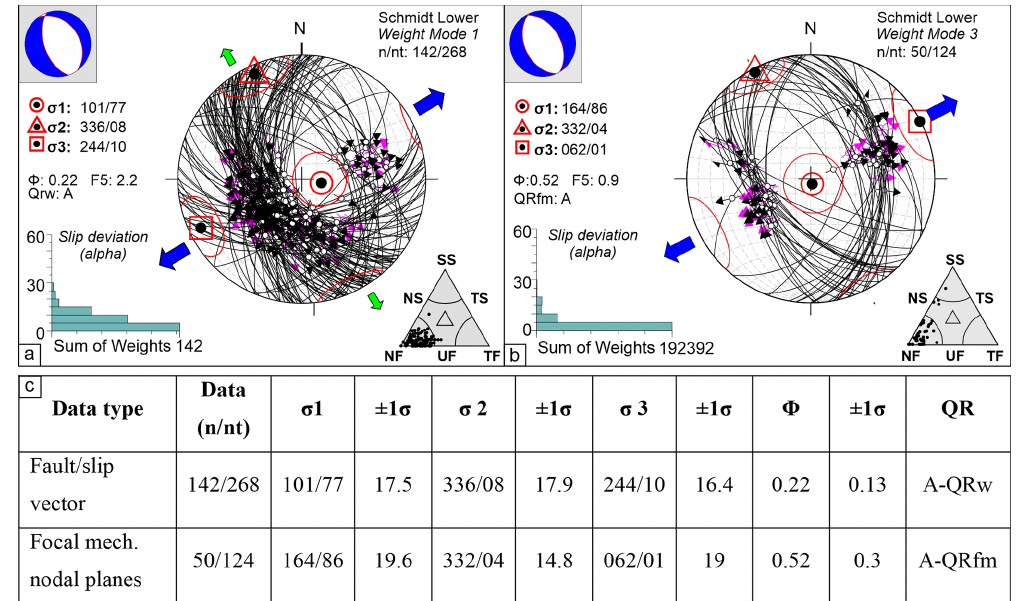
Figure 5. Stress inversion results for the geological (a) and seismological (b) data. On the lower hemisphere Schmidt nets, the fault plane/slickenline pairs (a) and focal plane/kinematic indicators (rake) (b) are reported (great circles represent the fault planes; the dark and pink arrows indicate the measured slip directions (or rake) and resolved shear stress respectively). The histograms represent the corre- sponding misfit angles vs. the number of data points; nt: total number of fault data; n : number of successfully inverted fault data; σ 1, σ 2, σ 3: principal stress axes; (cid:56) : stress ratio = ( σ 2– σ 3) / ( σ 1– σ 3); quality ranking factors (QR) and the stress inversion parameters with associated uncertainties (1 σ standard deviations) are listed in panel (c) . On the small upper left nets, the computed stress field represented as a focal mechanism is also reported. The triangles reported on the lower right corner of each panel (a) and (b) show the kinematic classification of data according to Frohlich (2001). (c) Geological and seismological stress tensor parameters computed starting from slip-vector measure- ments collected along the investigated fault systems (Figs. 2, 3) and focal mechanisms, respectively (see. Sect. 3 and Fig. 4). Key: nt: total number of data (e.g., plane/slickenline); n : inverted data; σ 1, σ 2, σ 3: principal stress axes; (cid:56) stress ratio = ( σ 2– σ 3) / ( σ 1– σ 3). QR: quality ranking; AQRw as in Sperner et al. (2003) and A-QRfm as in Heidbach et al.